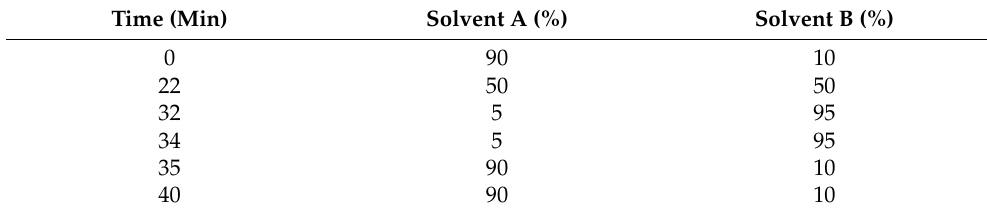
Table 9. HPLC Gradient for the separation of anthocyanins in grape skin